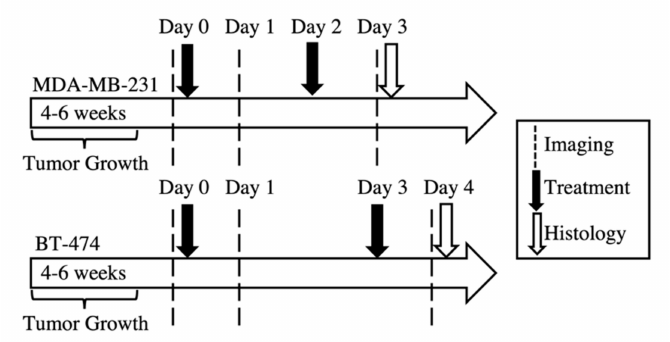
Figure 6. Tumor implantation, imaging, and treatment schedule for the tumor cohorts. MDA-MB-231 tumors were imaged on days 0, 1, and 3, while BT-474 tumors were imaged on days 0, 1, 4. MDA-MB-231 tumors were treated on day 0 (post-imaging) and day 2, with either saline (control), 15 mg / kg albumin-bound paclitaxel (ABP), or 25 mg / kg ABP treatment. BT-474 tumors were treated on days 0 (post-imaging) and 3, with either saline (control) of 10 mg / kg trastuzumab